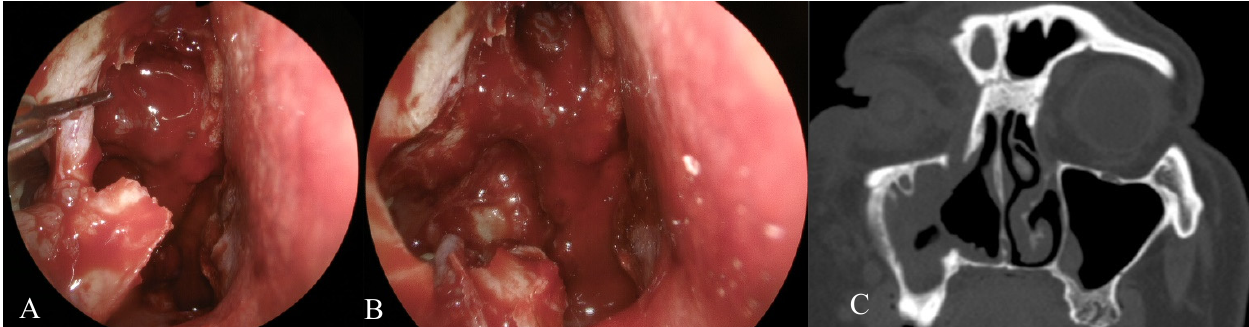
Figure 1. Transection of nasolacrimal duct at the level of orbital floor ( A ). Nasolacrimal duct removed, no additional procedures aimed at improving tear drainage were performed ( B ). Postoperative CT of the same patient—amputated nasolacrimal duct on the right side ( C ).